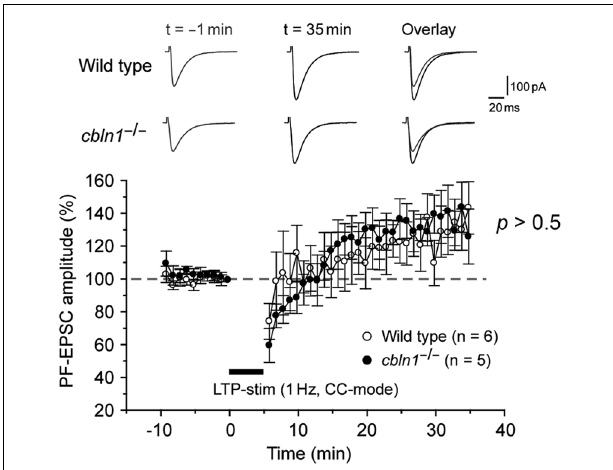
FIGURE 5 | LTP at PF–Purkinje cell synapses is normally induced in cbln1 − / − mice. A summary of LTP sessions in cerebellar slices prepared from wild-type and cbln1 − / − mice.The averaged amplitudes of the PF-EPSC over 1 min were normalized to the baseline value, which was the average of the 1 min responses (six traces) that occurred just before an LTP-inducing stimulation (300 times of single PF stimuli at a frequency of 1 Hz in the current-clamp mode). Inset traces show the PF-EPSCs just before ( t = − 1 min) or 35 min ( t = 35 min) after the LTP stimulation, and their superimposition (overlay). No differences were observed in PF-EPSC amplitudes after the LTP stimulation between wild-type and cbln1 − / − mice ( p > 0.5, wild type vs. cbln1 − / − mice, Mann–Whitney’s U test, n = 6 for wild type, n = 5 for cbln1 − / − mice).